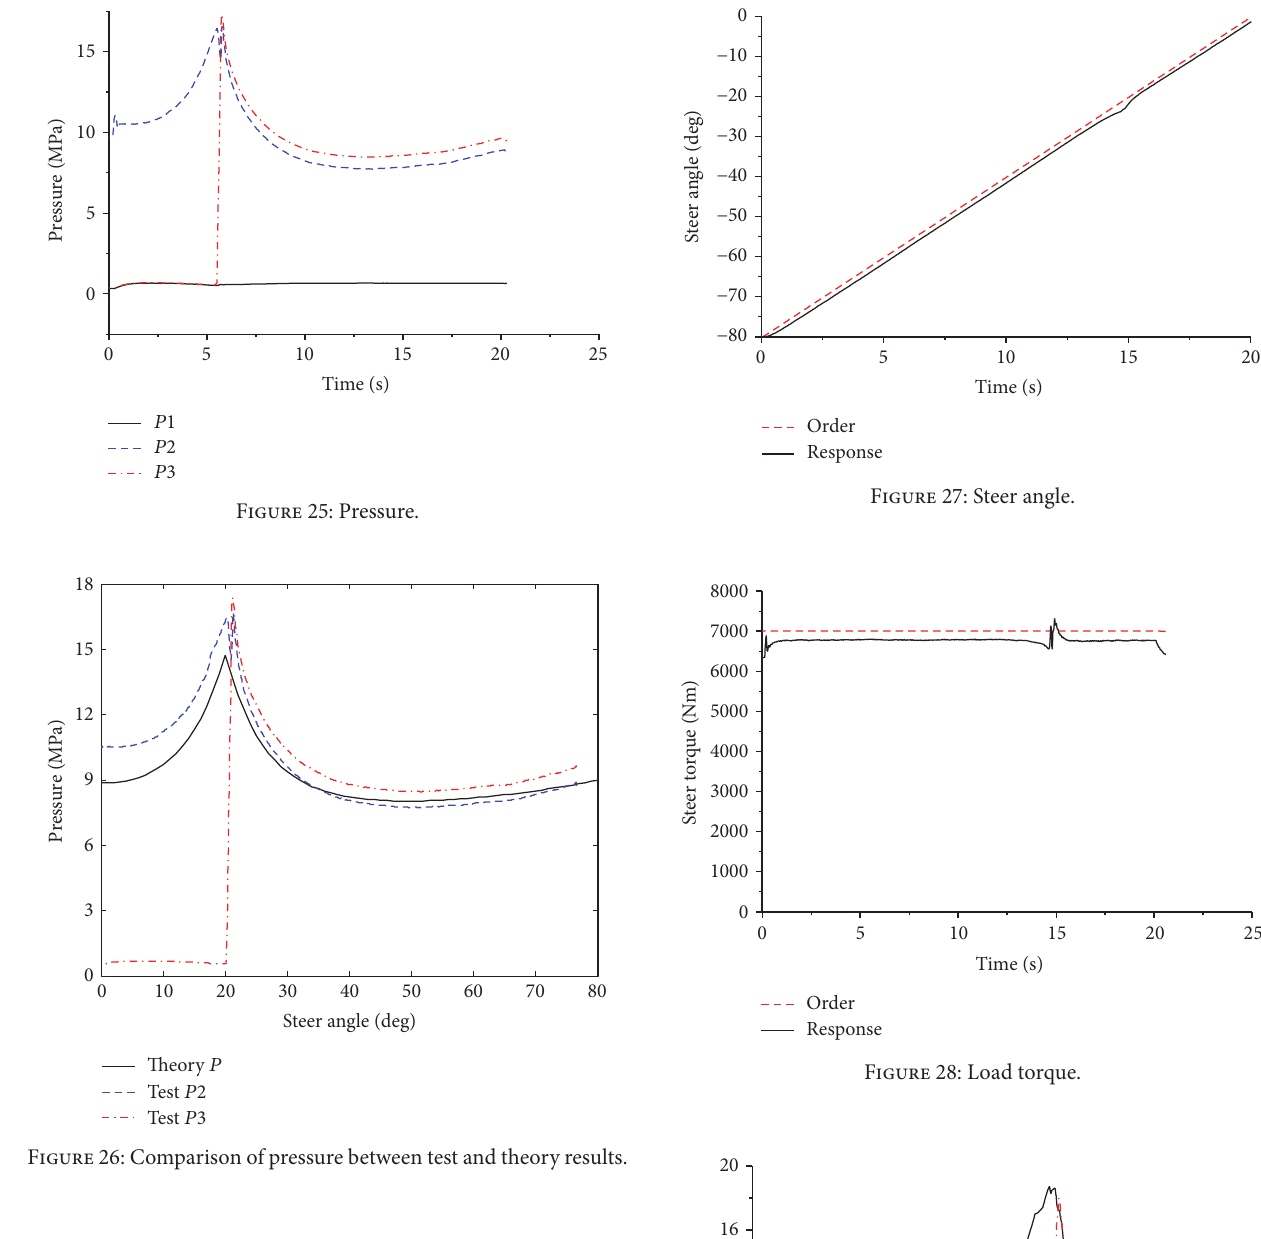
Figure 26: Comparison of pressure between test and theory results.